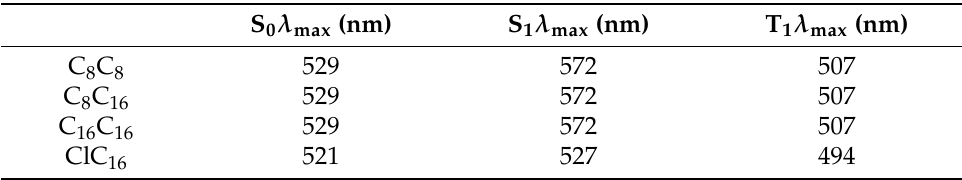
Table 4. Absorption maxima of the transitions measured in steady state absorption ( S 0 ) and in nanosecond transient absorption ( S 1 , T 1